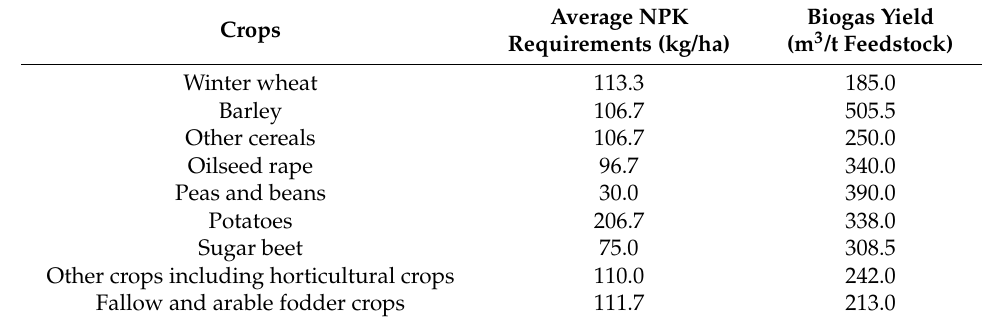
Table 2. Biogas Yield from crop feedstocks to AD [26]. NPK: nitrogen, phosphorus and